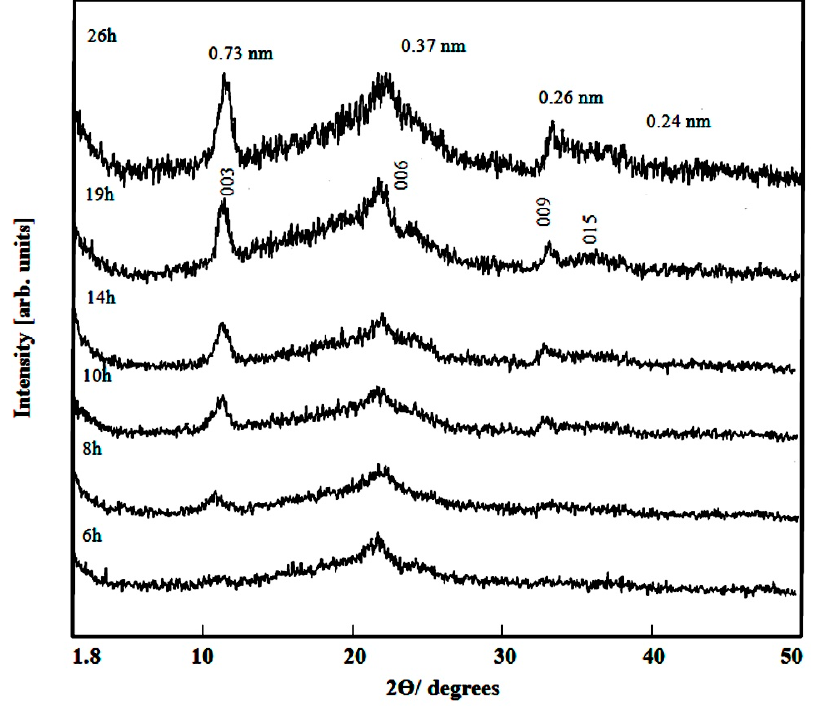
Figure 1. X-ray di ff raction of Ni-Ti-4 LDHs at di ff erent reaction Figure 1. X-ray diffraction of Ni-Ti-4 LDHs at different reaction times.